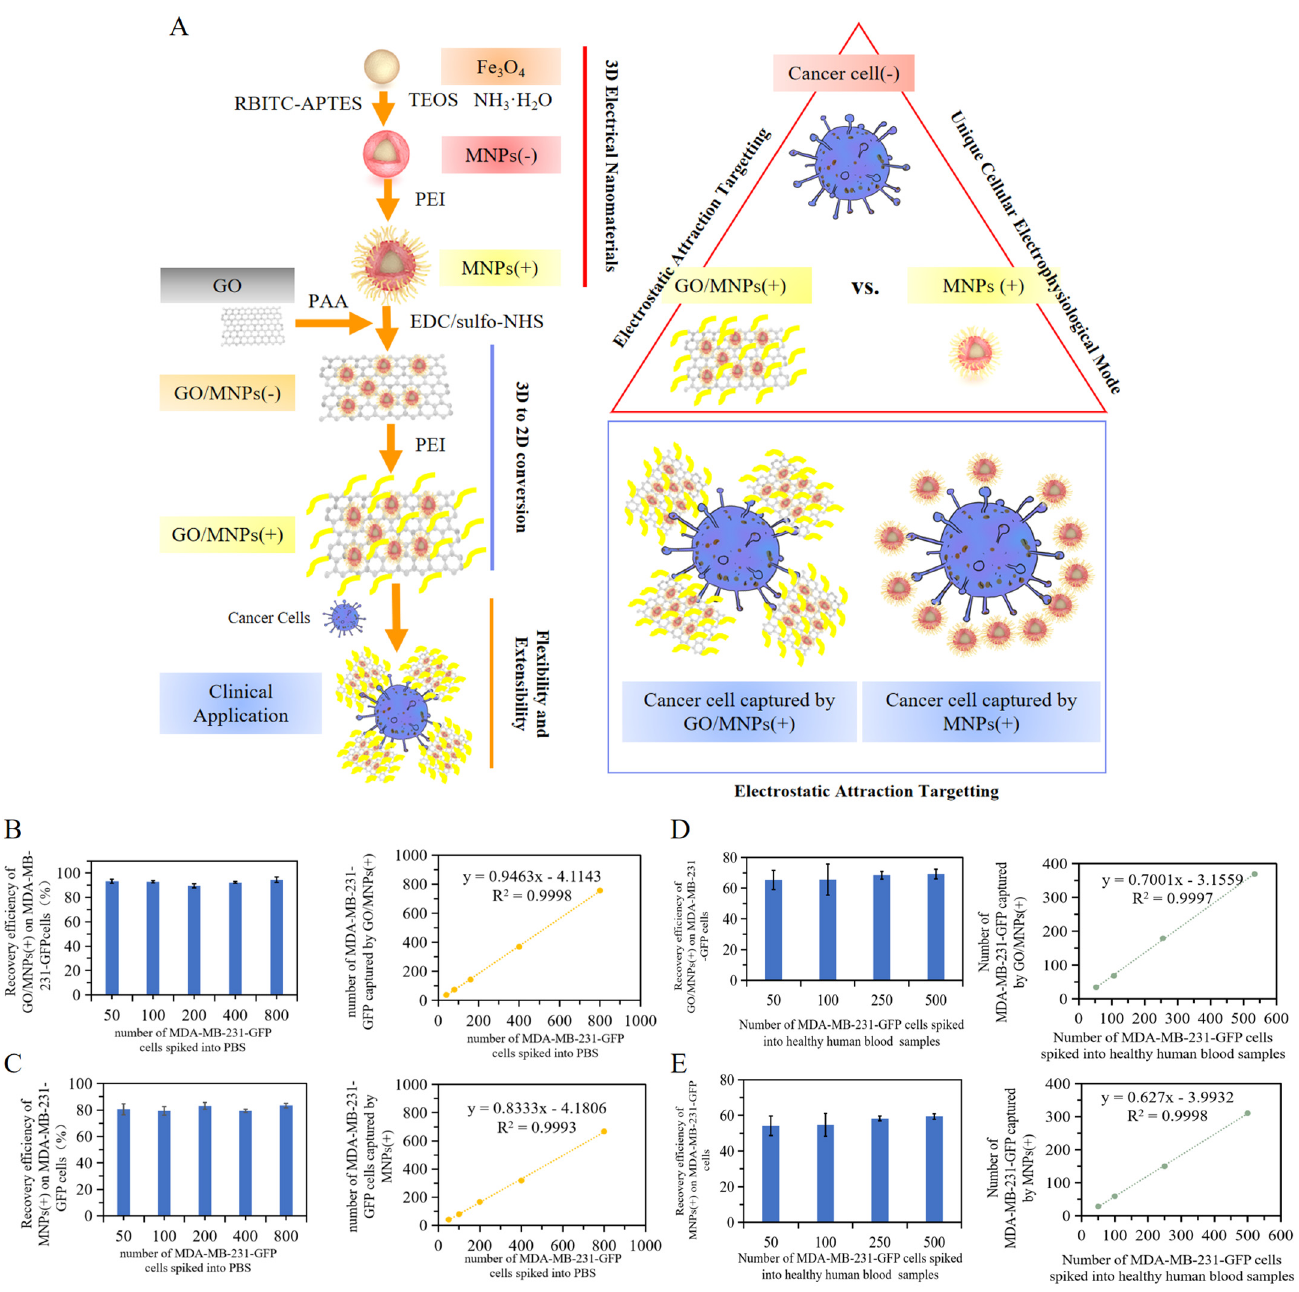
Figure 4. Comparation of 2D and 3D nanoprobe spatial specific-surface-area on electrostatic attraction binding. ( A ) conceptual diagram of interactions between GO/MNPs(+) and MNPs(+) with cancer cells. Recovery rates of ( B ) GO/MNPs(+) and ( C ) MNPs(+) on different numbers of gradient MDA-MB-231-GFP cancer cells in PBS; recovery rates of ( D ) GO/MNPs(+) and ( E ) MNPs(+) with different numbers of gradient cancer cells added to peripheral blood samples of healthy people. Linear correlation analysis between the number of GO/MNPs(+) and MNPs(+) recovered MDA-MB-231-GFP cancer cells and the number of MDA-MB-231-GFP cancer cells added to internal reference.